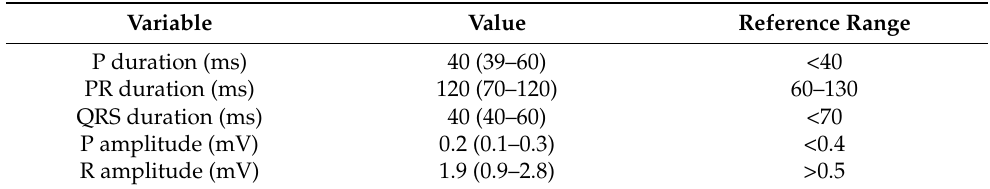
Table 1. Electrocardiographic variables reported as median (range) in 10 naturally infected dogs with chronic Chagas